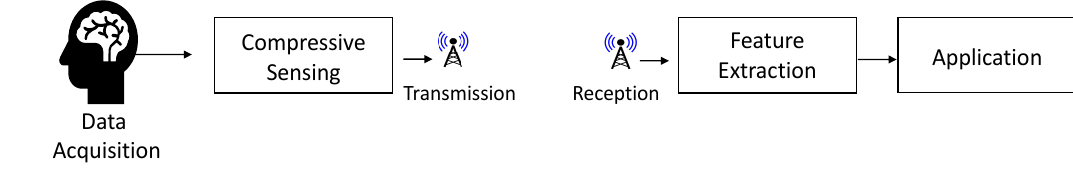
Figure 4. Block diagram of reconstruction free CS-based EEG